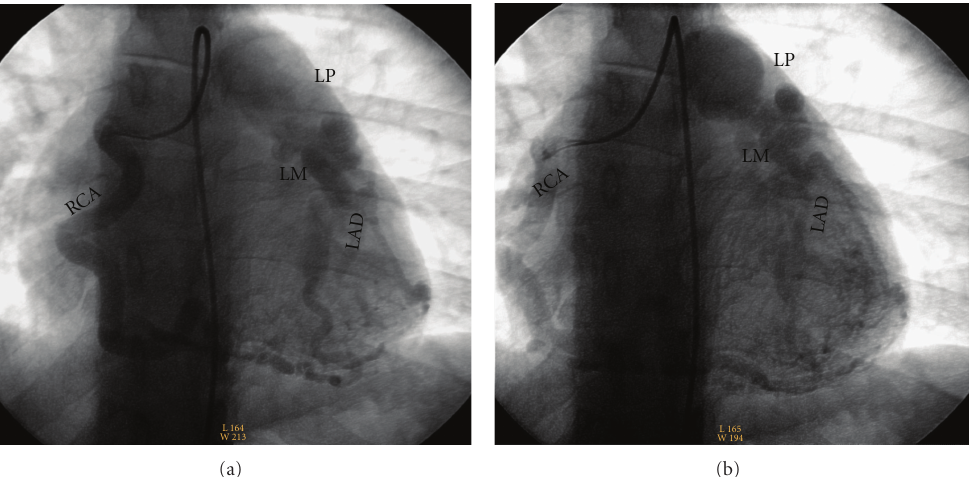
Figure 1: Coronary angiogram showing ALCAPA with left-to-right shunt. Retrograde filling was seen through collaterals arising from the enlarged right coronary artery (RCA), which gives rise to collaterals to a large left anterior descending artery (LAD) and left main artery (LMA) originated from the left main pulmonary (LP) trunk. The LAD and LMA are filling the pulmonary artery through a pronounced left-to-right